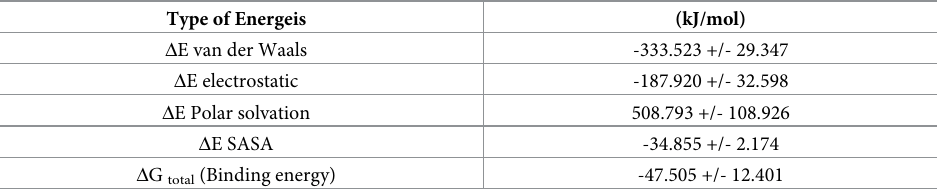
Table 4. Binding free energies from MM-PBSA calculation.